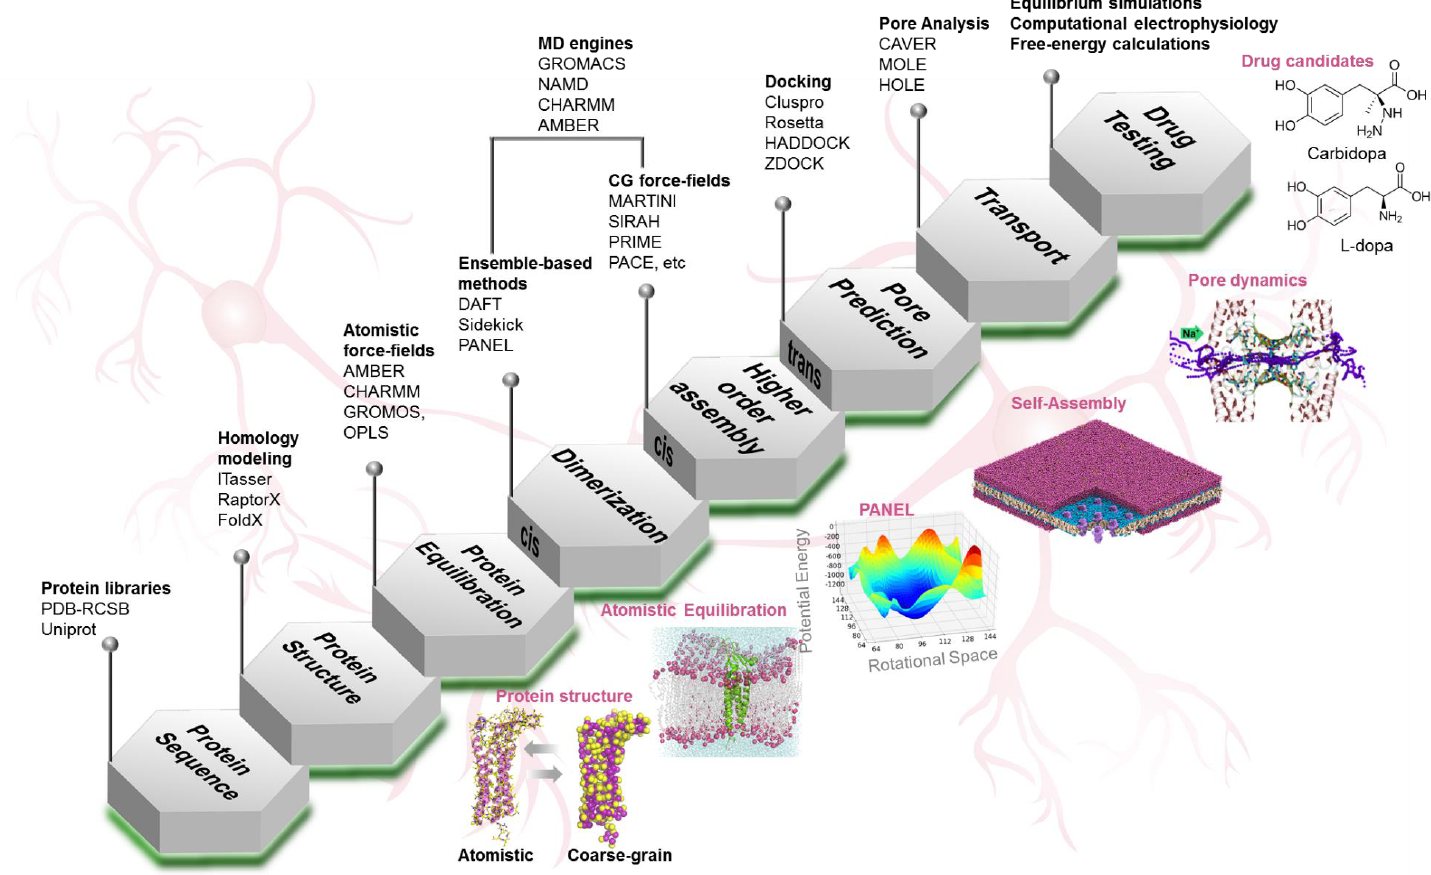
Figure 3. An overview of computational approaches and tools used to study the tight junctions at the blood–brain barrier. The stepwise research strategy included: obtaining protein sequence from online libraries; determining protein structure; equilibrating the protein in membrane lipids; investigating cis assembly (dimer and higher-order); investigating trans assembly for predicting tight junction barrier and pores; evaluating transport properties on ions and molecules; and testing tight junction modulators for enhanced drug delivery. The computational approaches (homology modeling, atomistic and coarse-grained molecular dynamics self-assembly simulations, PANEL, etc.) and tools (online libraries, webservers, force-fields, and software suites) associated with each step of our research strategy are also